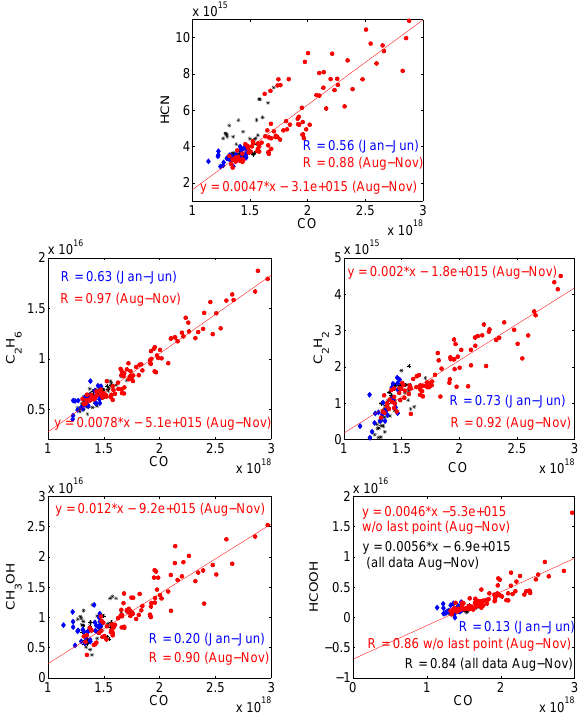
Fig. 6. Correlation plots of daily mean total columns of the five retrieved species versus CO (moleccm − 2 ). The correlation coef- ficient ( R ) is given for the periods from January to June (blue), and from August to November (red). For the latter period, the slope ( 1 X /1 CO) and the intercept from a linear least-squares fit of the data are also